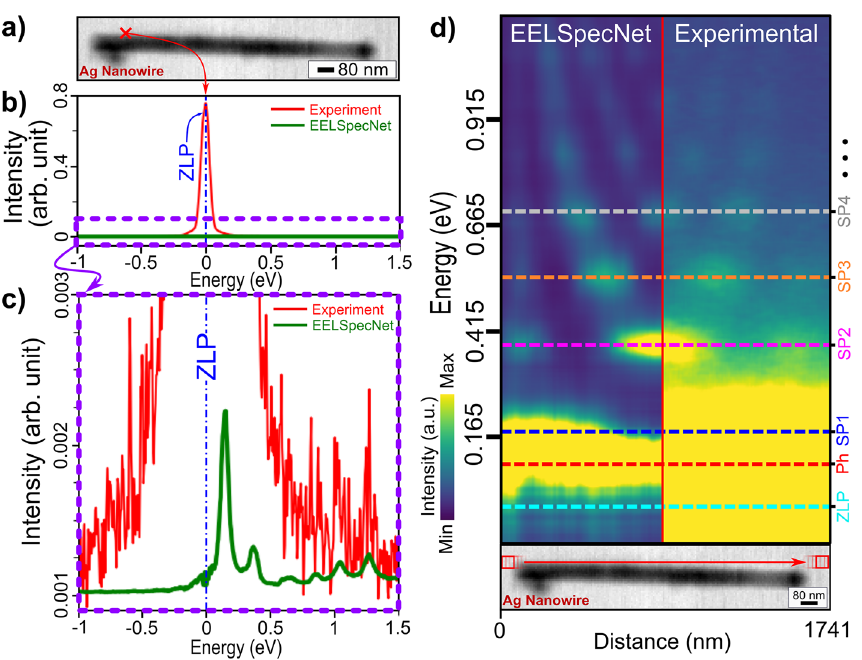
Figure 7. ( a ) Bright-field Scanning transmission electron microscope (BF-STEM) image of a silver nanowire. ( b ) A single NZ-EELS spectra captured from a point near the silver nanowire tip (red curve) and its EELSpecNet reconstruction signal (green curve). ( c ) Magnified experimental and EELSpecNet-restored spectra demonstrated in ( b ). ( d ) EELS map of the silver nanowire shown in ( a ). The map consists of averaged spectra capture along the nanowire (red arrow illustrated on the BF-STEM micrograph). The left side of the map contains EELSpecNet-restored data and the right side demonstrates the experimentally obtained spectra. Surface plasmon modal evolution in energy is marked for a few low energy modes (SP1 to SP4). A phonon peak related to the SiN substrate is also revealed in EELSpecNet-restored map at around 0.1 eV (marked as “Ph” on the